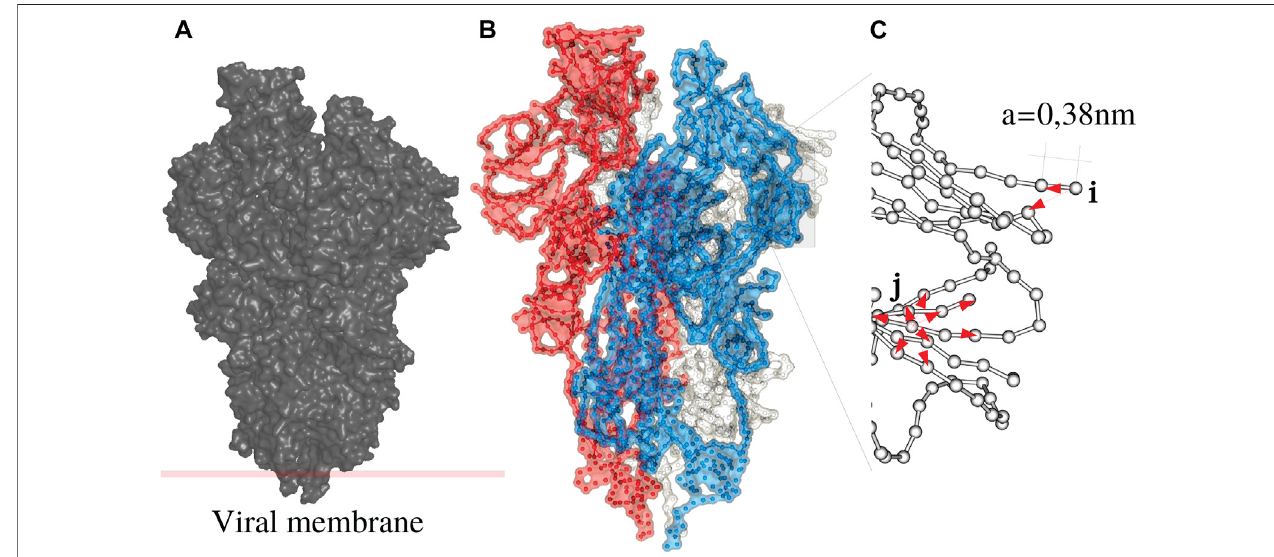
FIGURE1| TheSpike(S)proteinasanexampleofadisorderedsystem (A) consistsofthreemonomers (B) ,white,blueandred.Eachmonomer isaperiodicchain of amino acids with a period of 0.38 nm (C) . A protein is a folded chain where order and disorder intermingle.